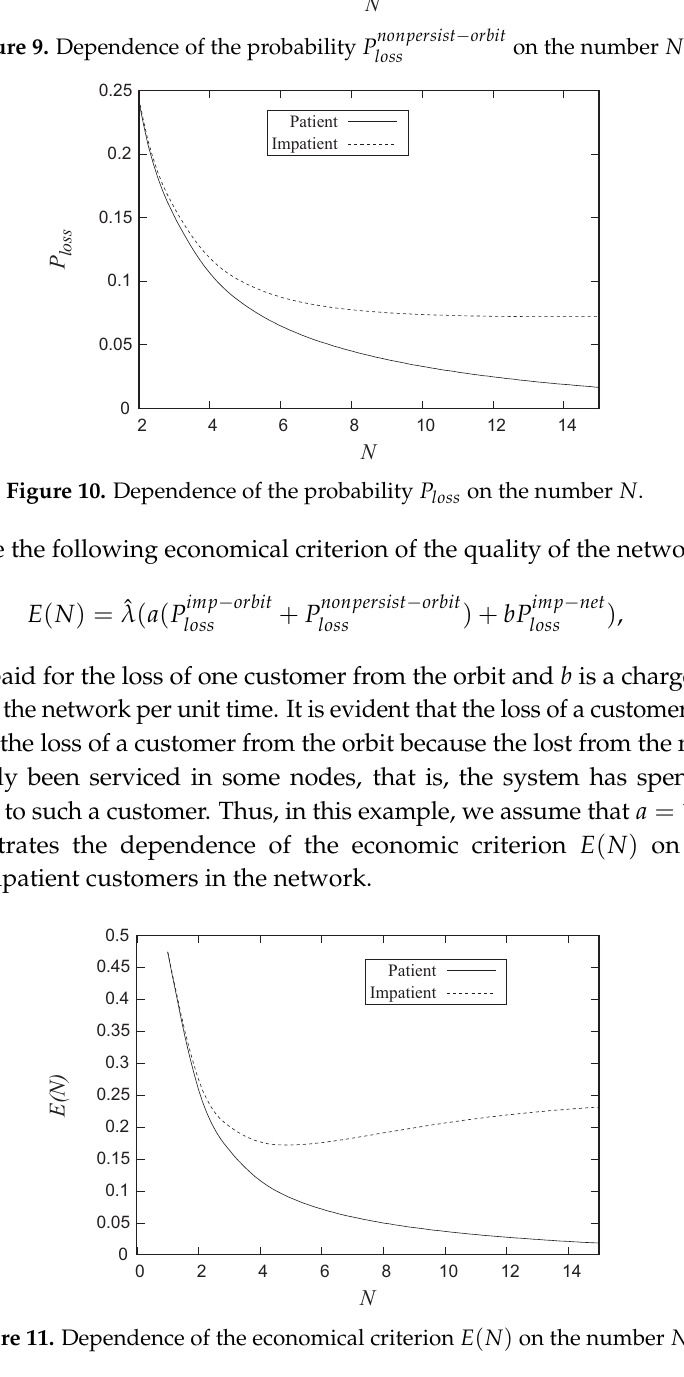
Figure 9. Dependence of the probability P nonpersist